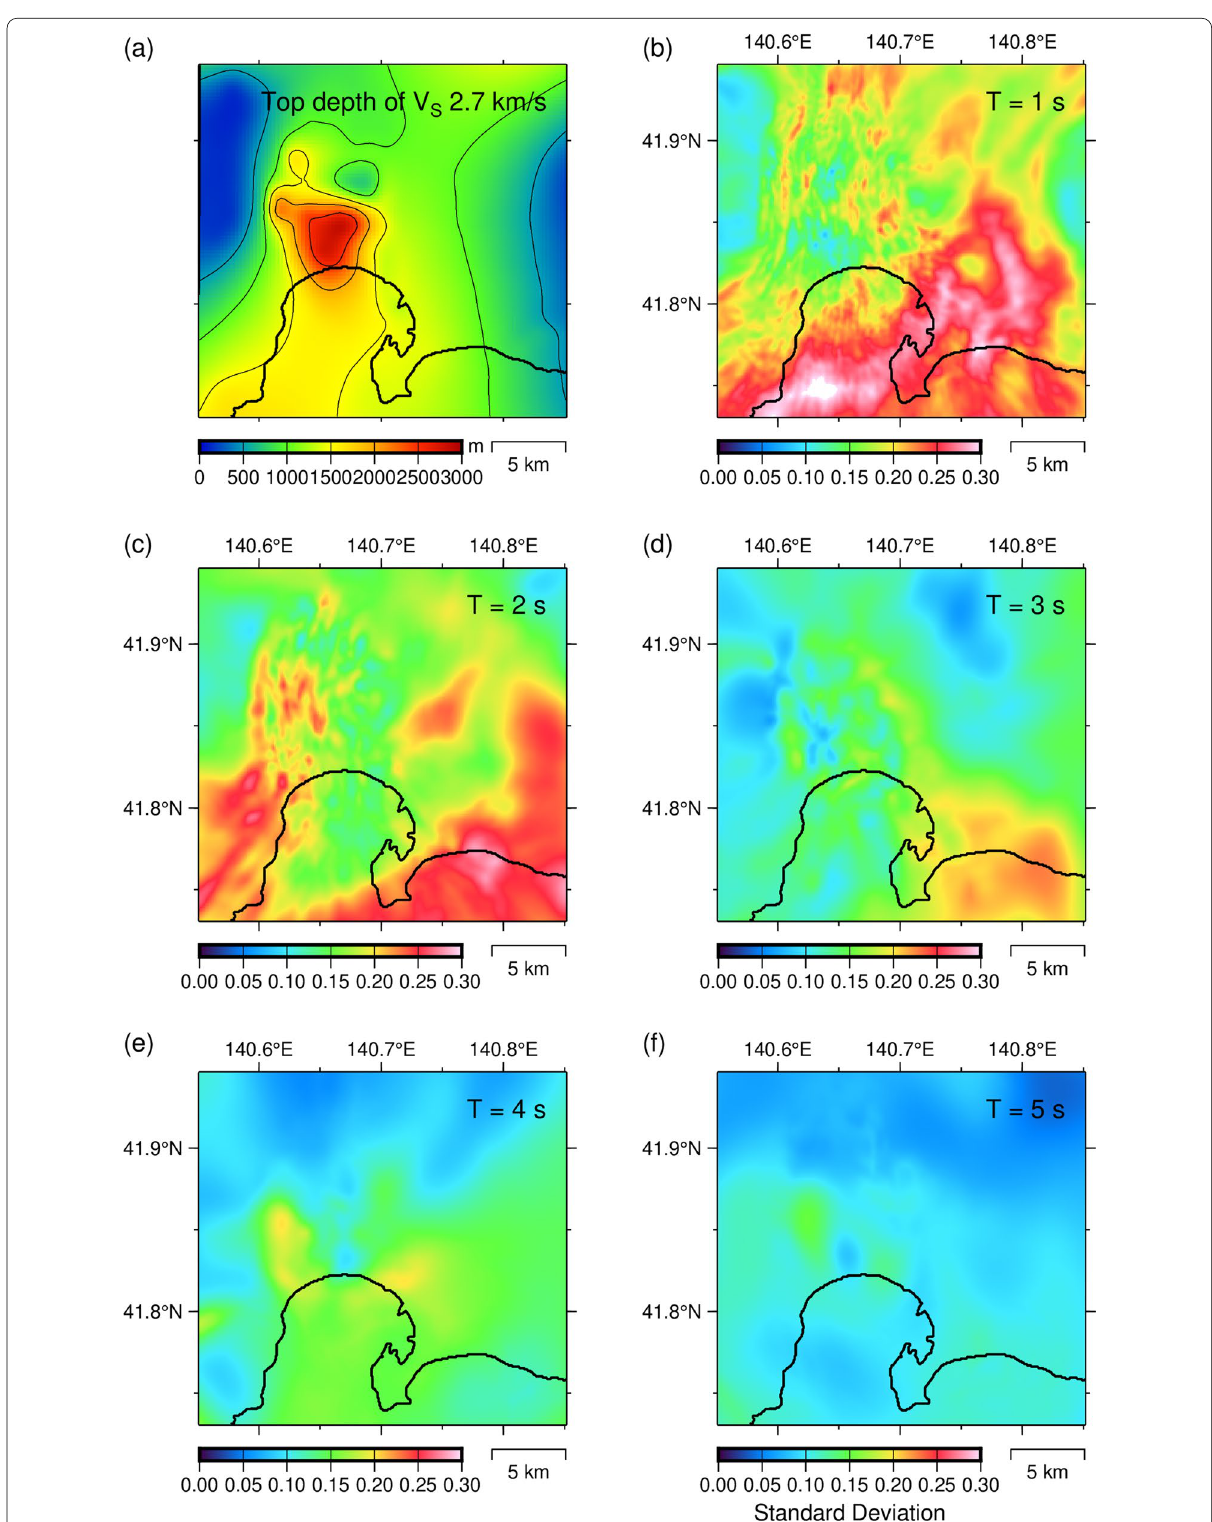
Fig. 16 The standard deviation of the amplification factor at each period. a The top depth of the layer for V S Plain. b – f The standard deviation of the amplification factors at each